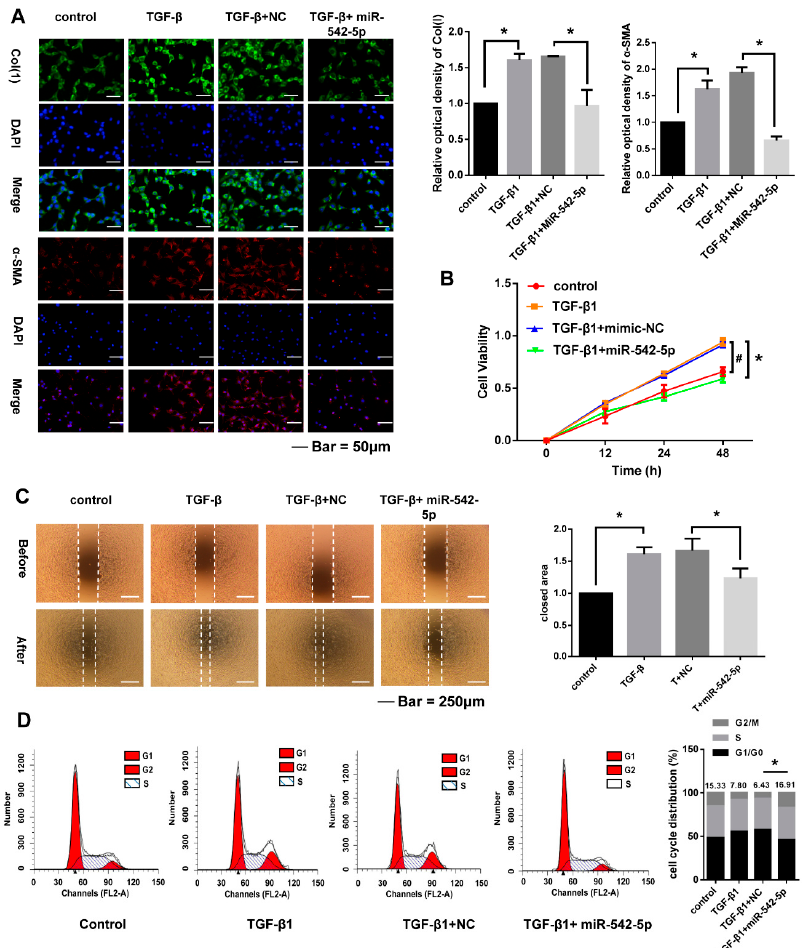
Figure 5. miR-542-5p inhibited the pro-fibrotic effect of TGF- β 1 on NIH-3T3 cells. ( A ) The fluorescence intensity of collagen I and α -SMA in NIH-3T3 cells co-treated with 5 ng/mL TGF- β 1 and 30 nM miR-542-5p mimic was notably lower than the cells treated with 5 ng/mL TGF- β 1; * p < 0.05 was considered to be statistically significant. ( B ) The proliferation ability of the NIH-3T3 cells co-treated with 5 ng/mL TGF- β 1 and the 30 nM miR-542-5p mimic was significantly reduced compared with the cells treated with 5 ng/mL TGF- β 1 48 h after treatment. # TGF- β 1+mimic NC group vs. Control group, * TGF- β 1+mimic NC group vs. TGF- β 1+miR-542-5p group. p < 0.05 for # and *. ( C ) The migration ability of NIH-3T3 cells co-treated with 5 ng/mL TGF- β 1 and 30 nM miR-542-5p mimic was notably lower than that of the cells treated with 5 ng/mL TGF- β 1,* p < 0.05 was considered statistically significant. ( D ) Flow cytometric analysis showed that the numbers of TGF- β 1 treated cells in S phase was increased remarkably compared to the control group, while the transfection of miR-542-5p mimic restored this increase on the cell cycle, * p < 0.05 was considered statistically